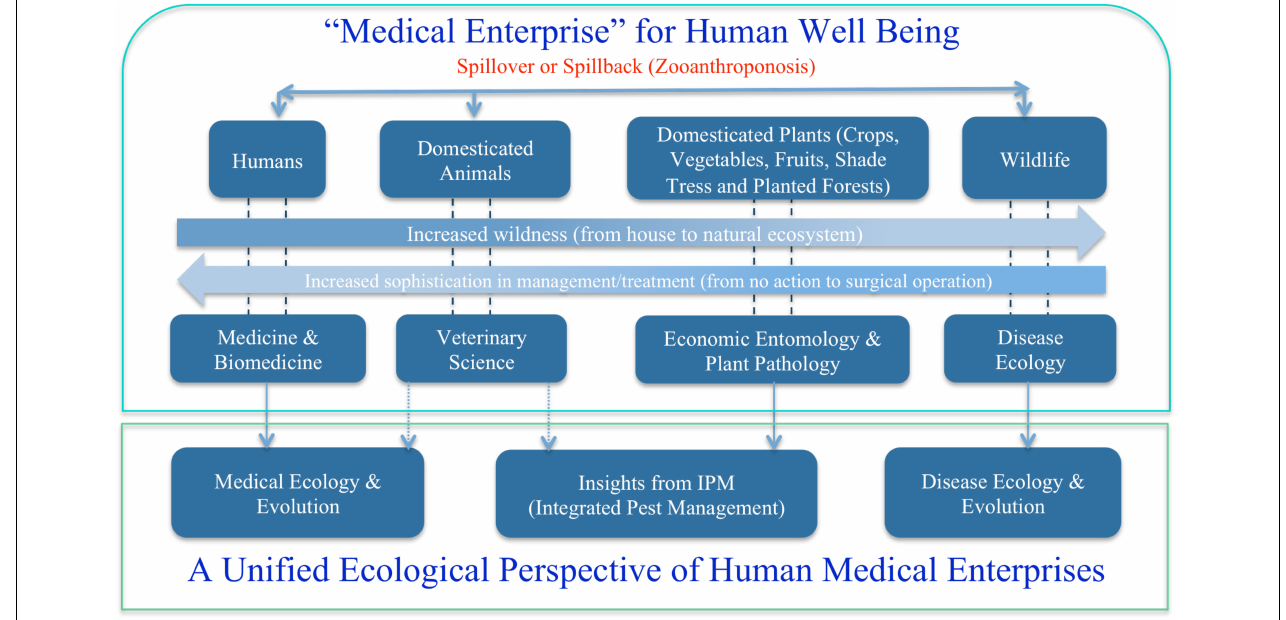
FIGURE 2 | A unified ecological perspective of the human medical enterprises (sciences and technologies): three fields or subjects—medical ecology for human diseases, integrated pest management (IPM) for diseases and insect pests of crops and forests, and disease ecology of wildlife.